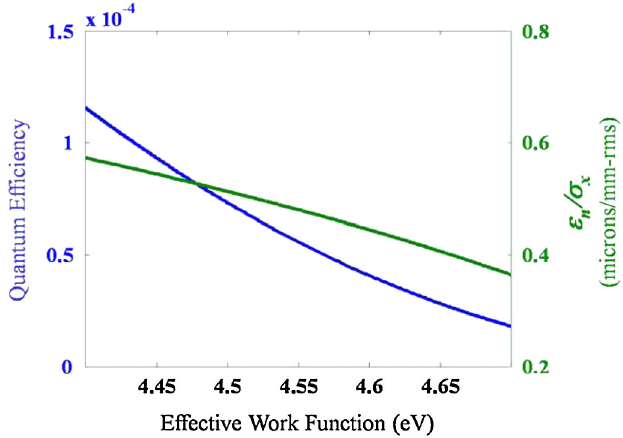
FIG. 7. (Color) The quantum efficiency and the normalized emittance per rms beam size plotted as functions of the effective work function, (cid:1) eff , for a photon energy of 4.90 eV ( (cid:4) laser ¼ 253 nm